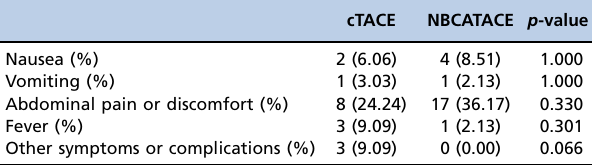
Table 3 - Post embolization symptoms and